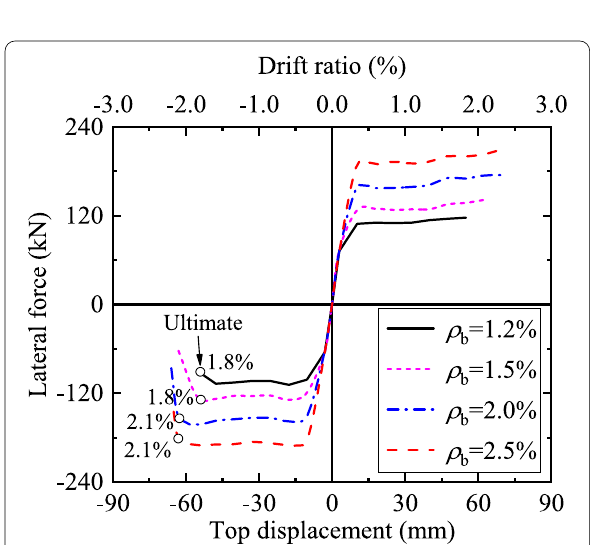
Fig. 20 Skeleton curves of specimens with different boundary longitudinal